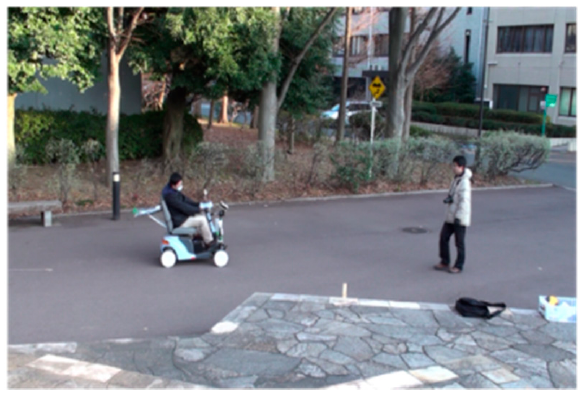
Figure 21. Experimental scene in daylight.